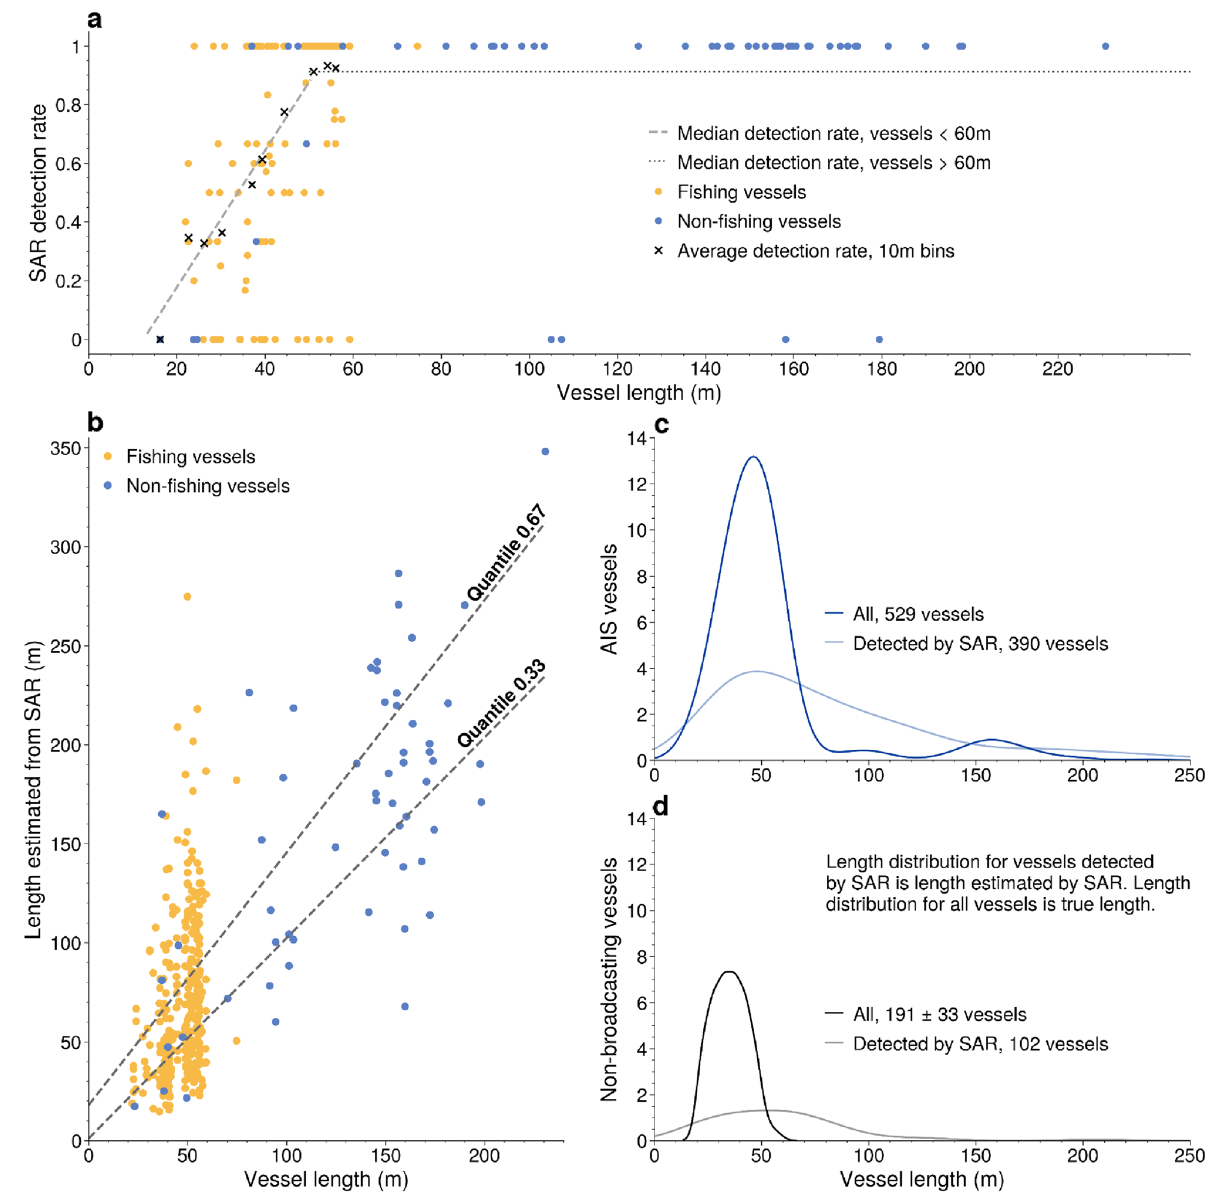
Figure 3. Relationships between SAR estimated length and actual length, and between length and SAR detection rate allow us to estimate the true distribution of non-broadcasting vessels. ( a ) For vessels under 60 m in length, the rate of detection with SAR increases linearly with length, while above 60 m it appears roughly constant, with only a few very large vessels undetected. Vessels that appeared in multiple scenes have fractional detection rates (between 0 and 1). ( b ) For vessels with AIS that matched to SAR detections, the length estimated from SAR shows high variability compared to the actual length of vessels, with quantile fits shown for the 33rd and 67th percentiles. ( c ) The distribution of actual lengths of the 529 vessels with AIS likely within the SAR scenes (dark blue curve) and the corresponding distribution of SAR estimated length for the 390 of these vessels detected by SAR (light blue curve). ( d ) The distribution of SAR estimated lengths of the 102 SAR detections of non-broadcasting vessels (gray curve), and, based on the relationships in A and B, the estimated most likely distribution of actual non-broadcasting vessels (black